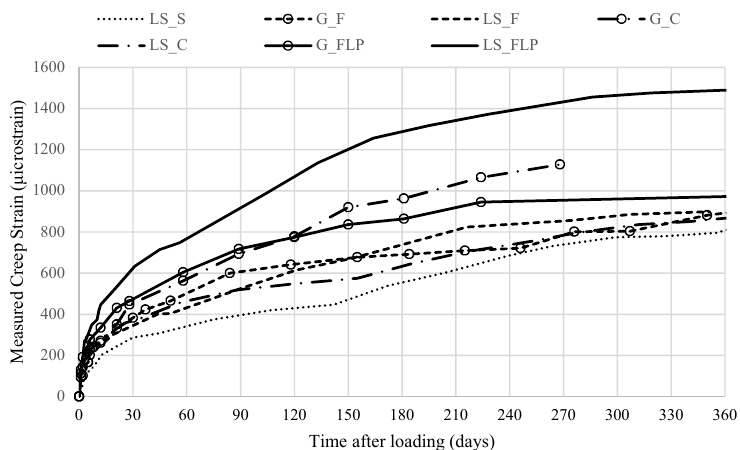
Figure 5. Measured creep strain versus time after loading for all SCC mixtures.